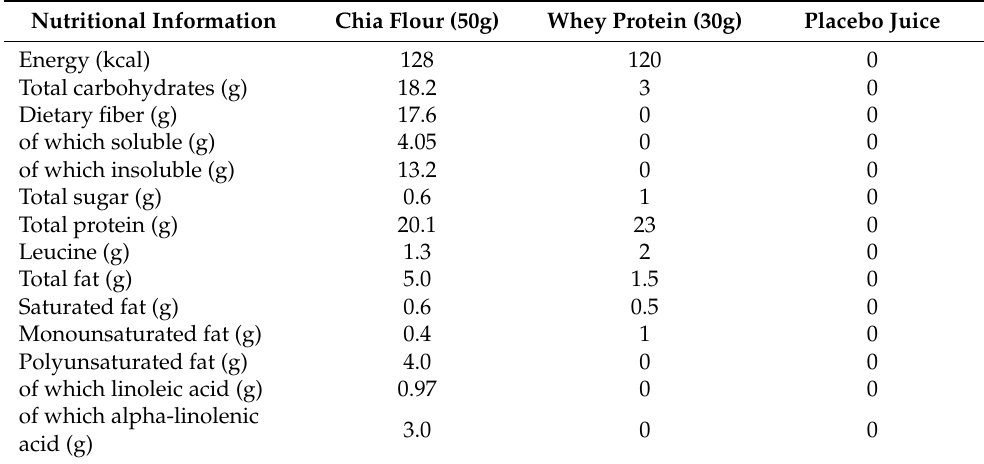
Table 1. Nutritional information for the chia flour, whey protein and the placebo juice. Nutritional